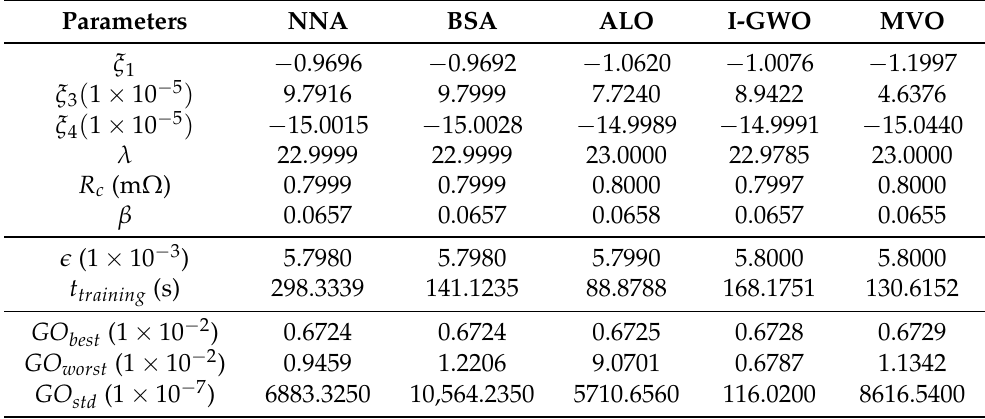
Table 8. Unknown parameters computed and performance information for the modeled polarization curve at 66%